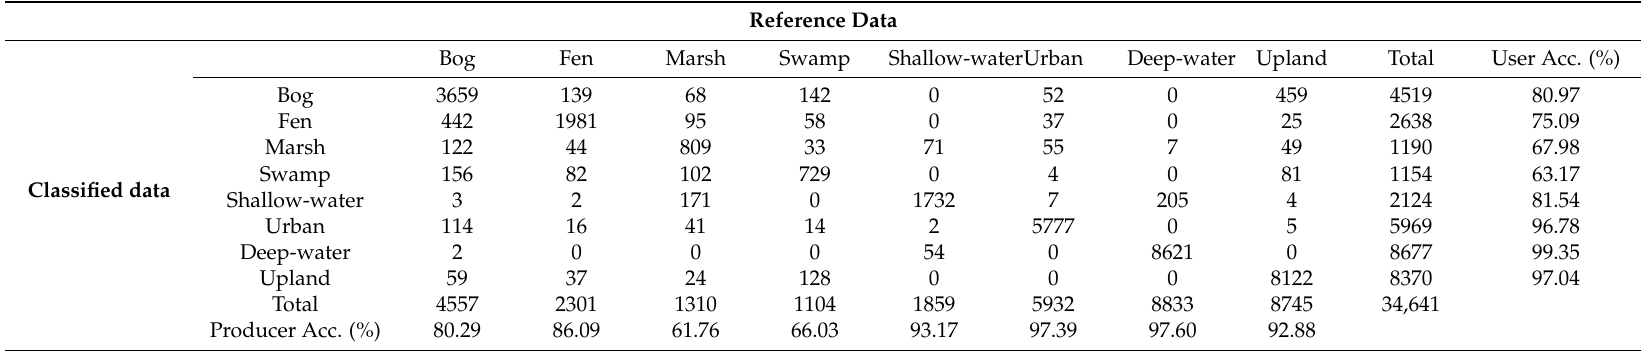
Table 5. The confusion matrix of the Avalon classification map obtained from the FP SAR data. An overall accuracy of 90.73% and Kappa coefficient of 0.88 were achieved.